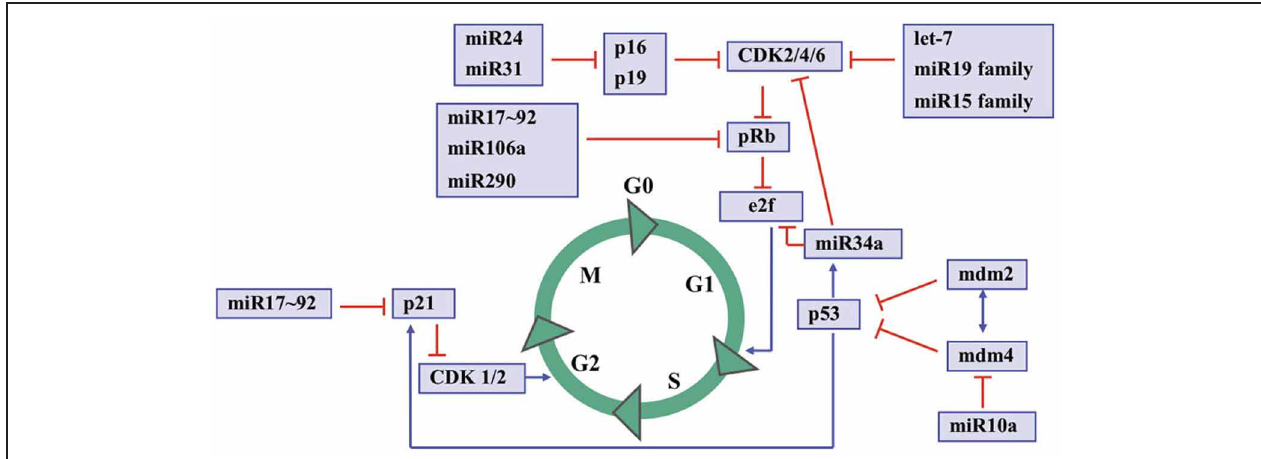
FIGURE 2 | An overview to cell cycle control by microRNAs and some key proteins. S indicates the S-phase; M indicates the mitosis; G1 and G2 indicate transition phases of the cell cycle whereas G0 indicates quiescent